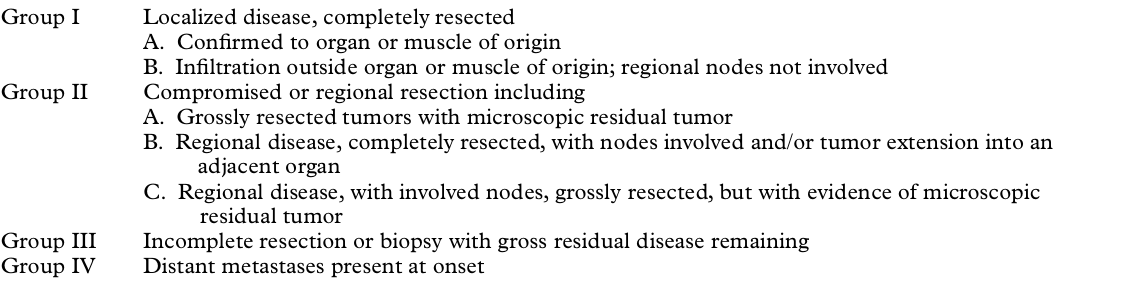
Table 3. Intergroup rhabdomyosarcoma study clinical grouping system Group